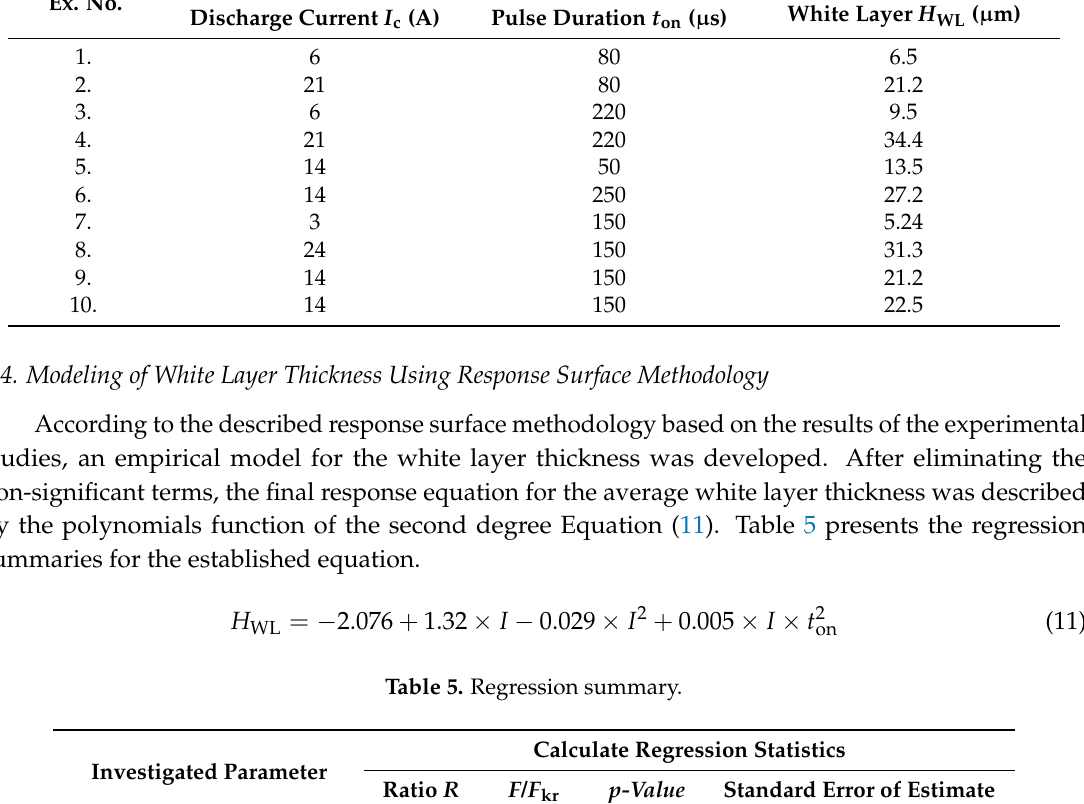
Table 4. Design of experimental matrix and results for thickness of the white layer. Ex. No.